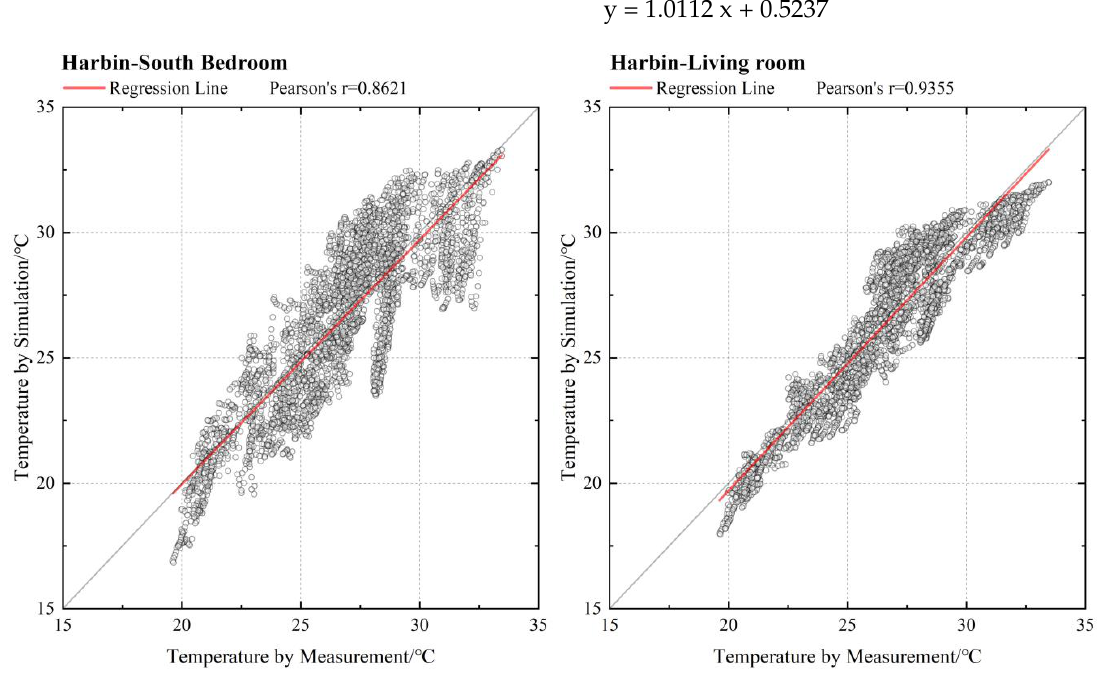
Figure 7. Correlation between measured data and simulation results of south-facing bedroom and living room during summertime of 2021.